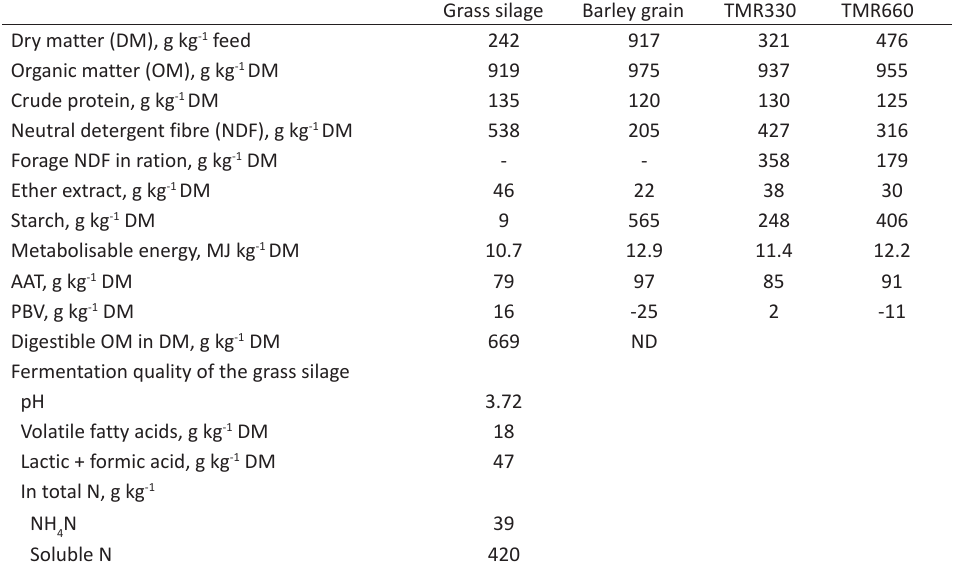
Number of samples: grass silage 14, barley grain 5. TMR330 = concentrate level 330 g kg -1